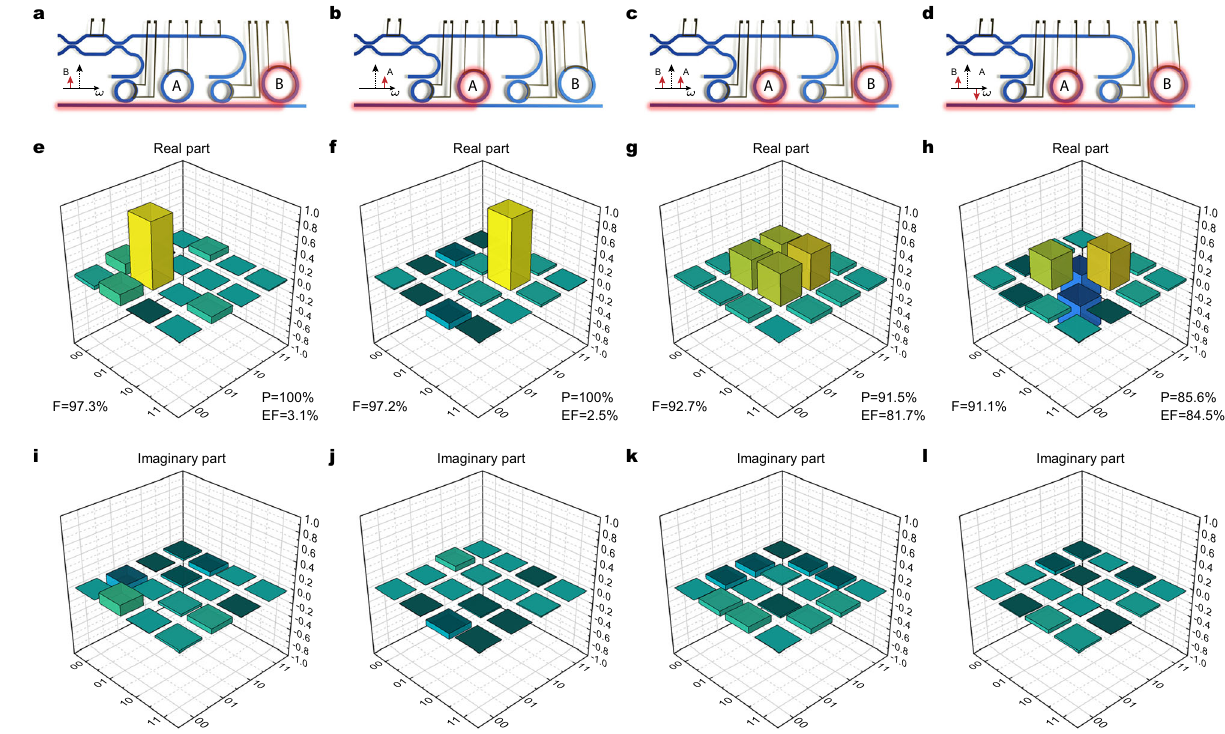
Fig. 6 | Quantum state tomography in the f ∣ 01 i , ∣ 10 ig basis ( Ψ con fi guration). Columns from left to right refer respectively to states: ∣ 01 i , ∣ 10 i , ∣ Ψ + a – d Device pumping scheme. The bus waveguide is used as input for the pump, whereas the generation rings' resonances are addressed by spectral shaping